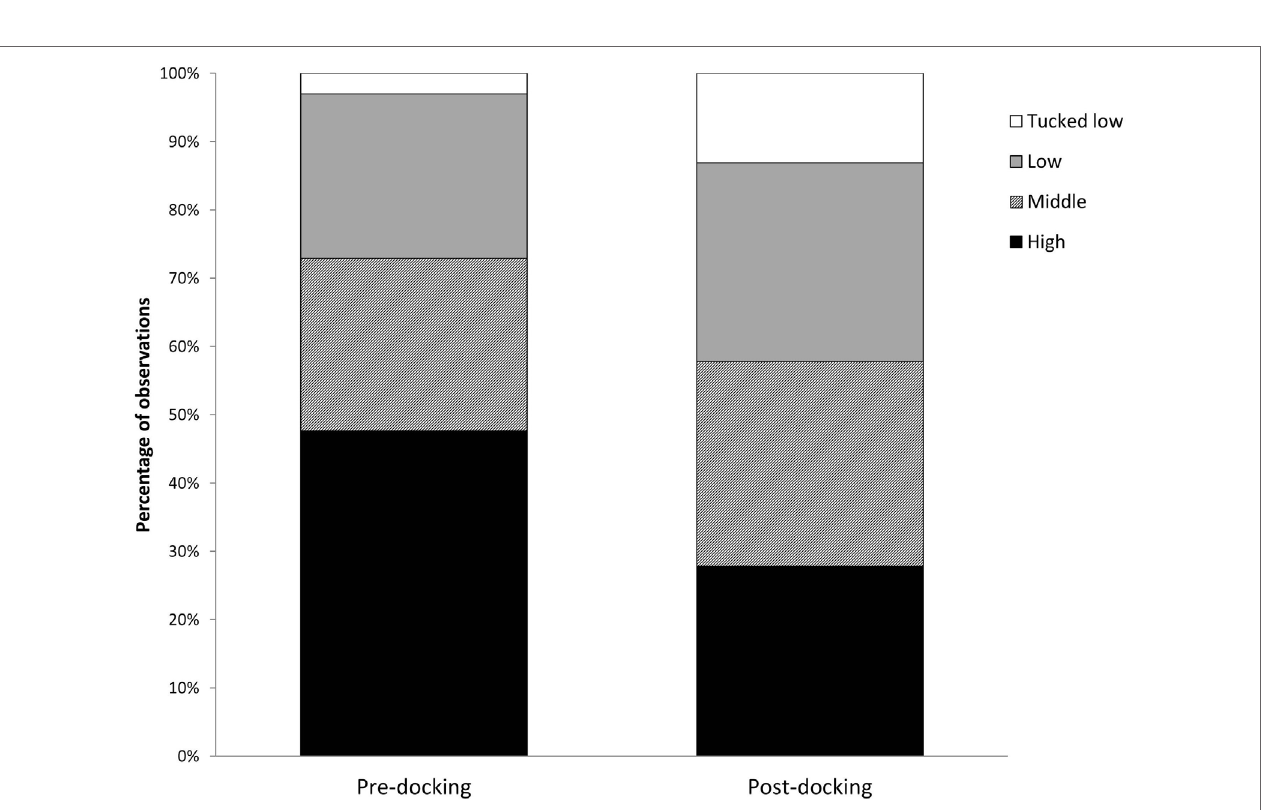
FigUre 6 | changes in tail posture . Percentage of total observations of tail posture carried out pre and immediately post-tail docking.